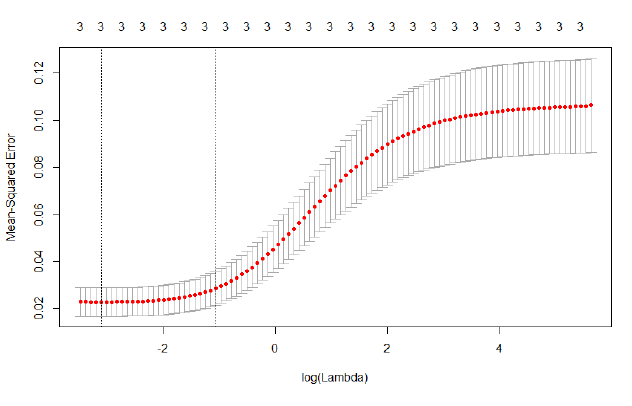
Fig. 7. MSE versus log (  ) of ridge regression model